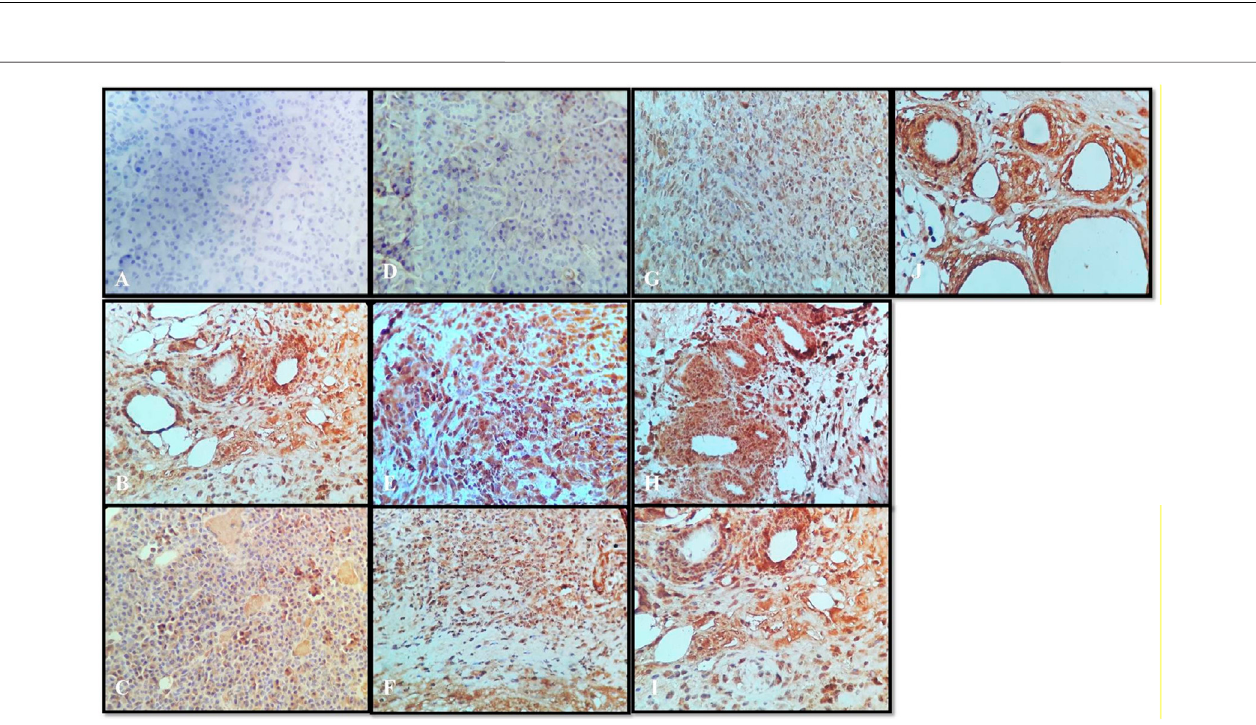
FIGURE 9 | Immunochemistry VEGF: (A) normal control, (B) disease control, (C) marketed standard, (D) Thymoquinone Std, (E) α -pinene Std, (F) β -pinene Std, (G) N. sativa extract, (H) N. sativa oil, (I) berberine Cl Std, (J) Berberis aristata extract.